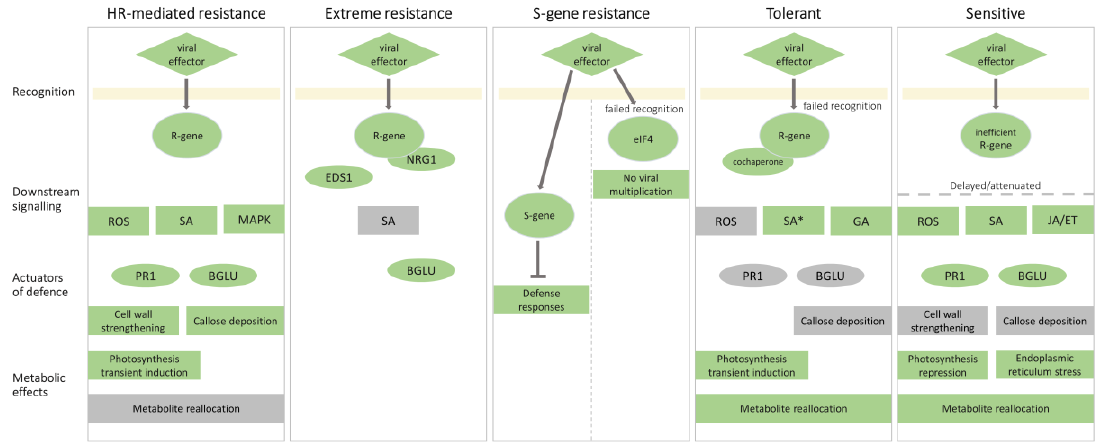
Figure 2. Comparison of molecular responses to PVY resulting in different outcomes. Molecular events involved in virus recognition, downstream signaling, defense responses, and metabolic effects in resistant and susceptible outcomes are presented. The components (genes, proteins, and processes) that were shown to be involved in a particular outcome are highlighted in green, while the components that were shown not to be involved in a specific outcome are highlighted in grey. In hypersensitive response (HR)-mediated resistance, the viral effector (e.g., helper component proteinase, HC-Pro) is recognized by the R-gene (e.g., Ny-1 or Ny-Smira ), which activates reactive oxygen species (ROS) signaling (mediated by, e.g., Respiratory Burst Oxidase Homolog D, RBOHD), mitogen-activated protein kinase kinase (MAPK) cascades (e.g., MAPK4_2, MAPK6, MAPK13, and MAPK kinase 6, MKK6) and salicylic acid (SA) signaling. Resistance is mediated by changes in PR1 ( pathogenesis-related gene 1 ) and BGLU ( β -1,3-glucanase gene ) expression, cell wall strengthening, and callose deposition. Transient induction of photosynthesis is observed. In extreme resistance, the viral effector (e.g., HC-Pro) is recognized by the R-gene (e.g., Ry sto ), but N requirement gene 1 (NRG1) is required for activation of downstream signalling, which depends on Enhanced Disease Susceptibility 1 (EDS1). BGLU ( Glu-III ) is involved in viral restriction. S (susceptibility)-gene mediated resistance depends on either a mutation in eukaryotic translation initiation factor 4 (eIF4), which prevents viral multiplication, or on an altered S-gene, which inhibits defense responses. Tolerant interaction can be a consequence of failed recognition of an R-gene (e.g., TPN1 ) or cochaperone (e.g., Hop/Sti1) required for virus multiplication. Downstream signaling involves gibberellins (GA). SA is not increased but has an important role in the establishment of tolerance. ROS, PR1, BGLU, and callose deposition are not involved. Photosynthesis transient induction and metabolite reallocation are observed. In sensitive interaction, the viral effector is recognized by an inefficient R gene, leading to delayed or attenuated downstream ROS, SA and jasmonic acid/ethylene (JA/ET) signaling, and PR1 and BGLU induction. Cell wall strengthening and callose deposition are absent. Metabolic effect feature photosynthesis repression, endoplasmic reticulum stress and metabolite reallocation. Other mechanisms, leading to this outcome are possible.